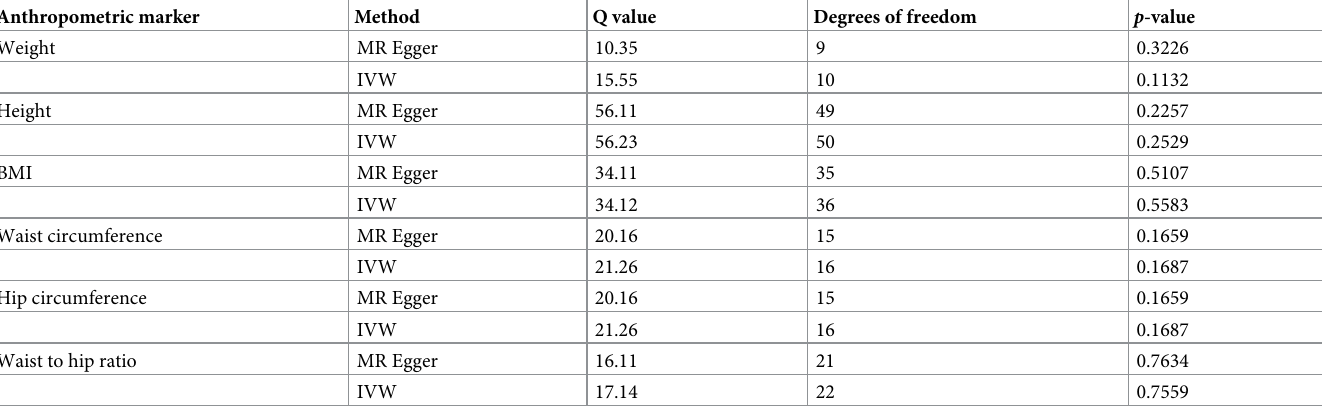
Table 3. Heterogeneity statistics of two-sample Mendelian randomization analyses. Anthropometric